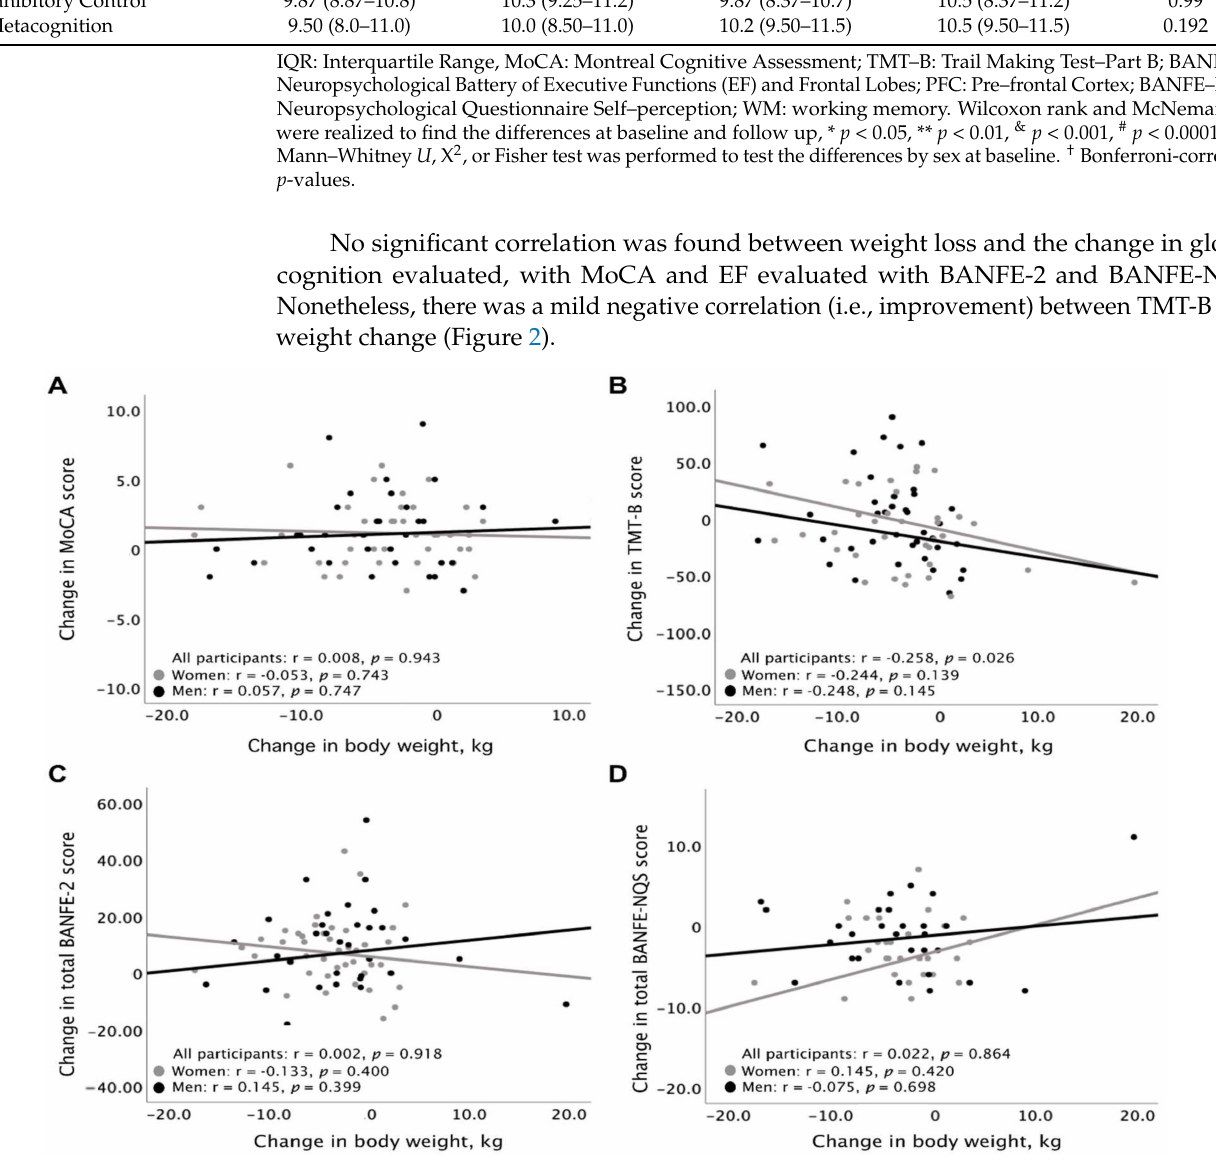
Figure 2. Scatter plot showing the correlation between the change in body weight with change in MoCA score ( A ), change in TMT-B score ( B ), change in BANFE-2 score ( C ), and with change in BANFE-NQS ( D ). MoCA: Montreal Cognitive Assessment; TMT–B: Trail Making Test–Part B; BANFE–2: Neuropsychological Battery of Executive Functions (EF) and Frontal Lobes; BANFE–NQS: Neuropsychological Questionnaire